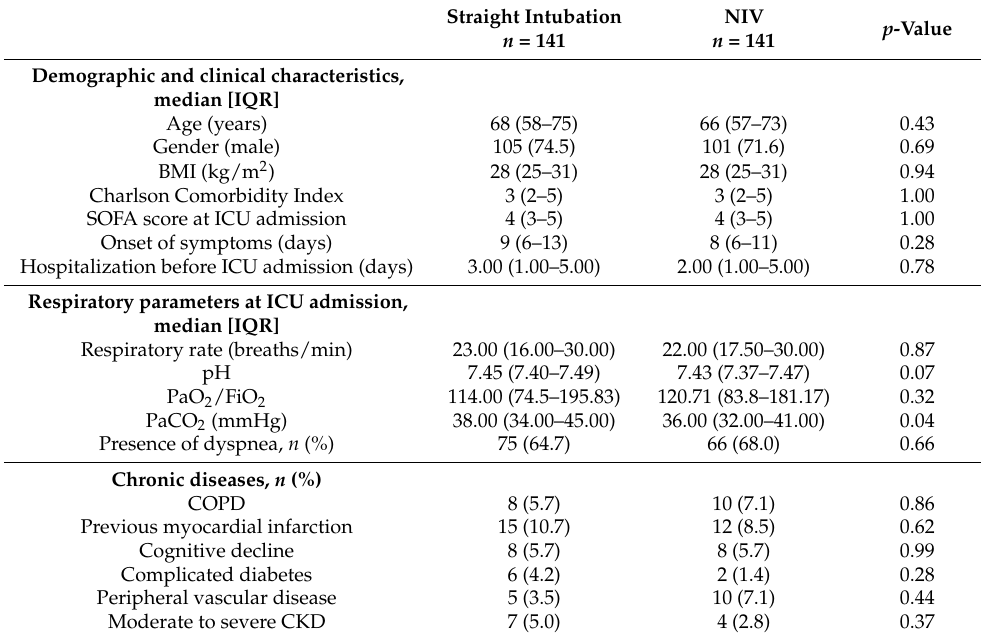
Table 1. Differences between groups at ICU admission after propensity score matching.